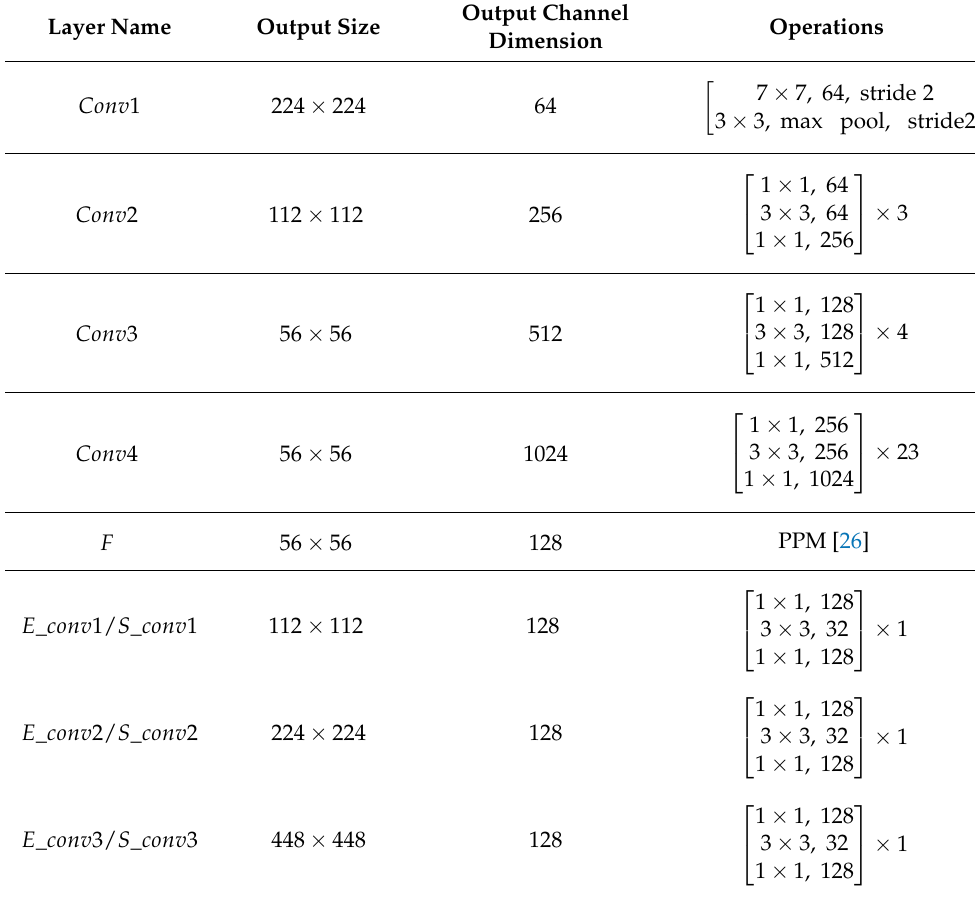
Table 1. Architecture of the proposed method. The input image size is 448 ×